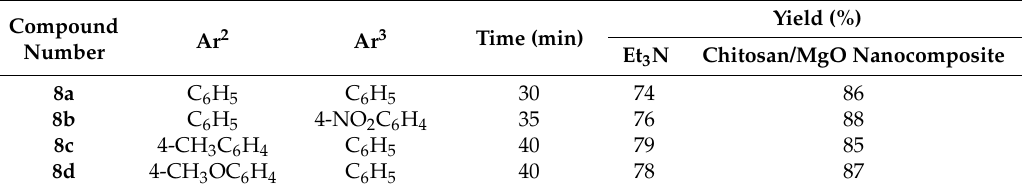
Table 3. Effect of the nature of basic catalyst on the yield of the products 8a – d